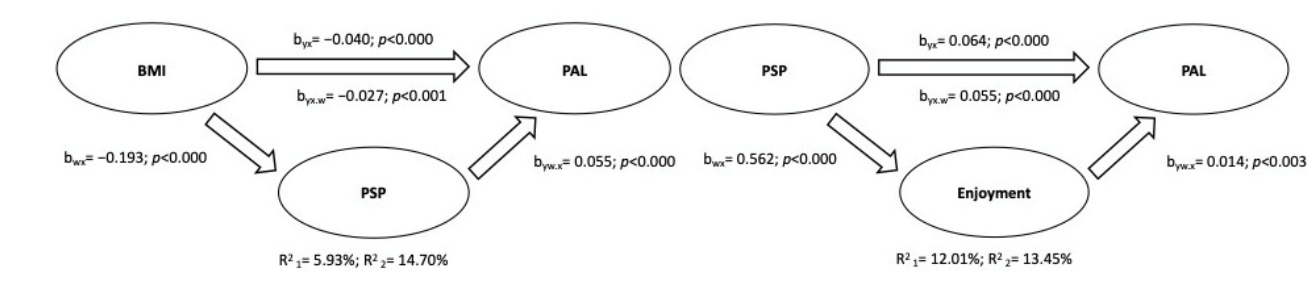
Figure 4. Mediation Analysis of Male Sample.